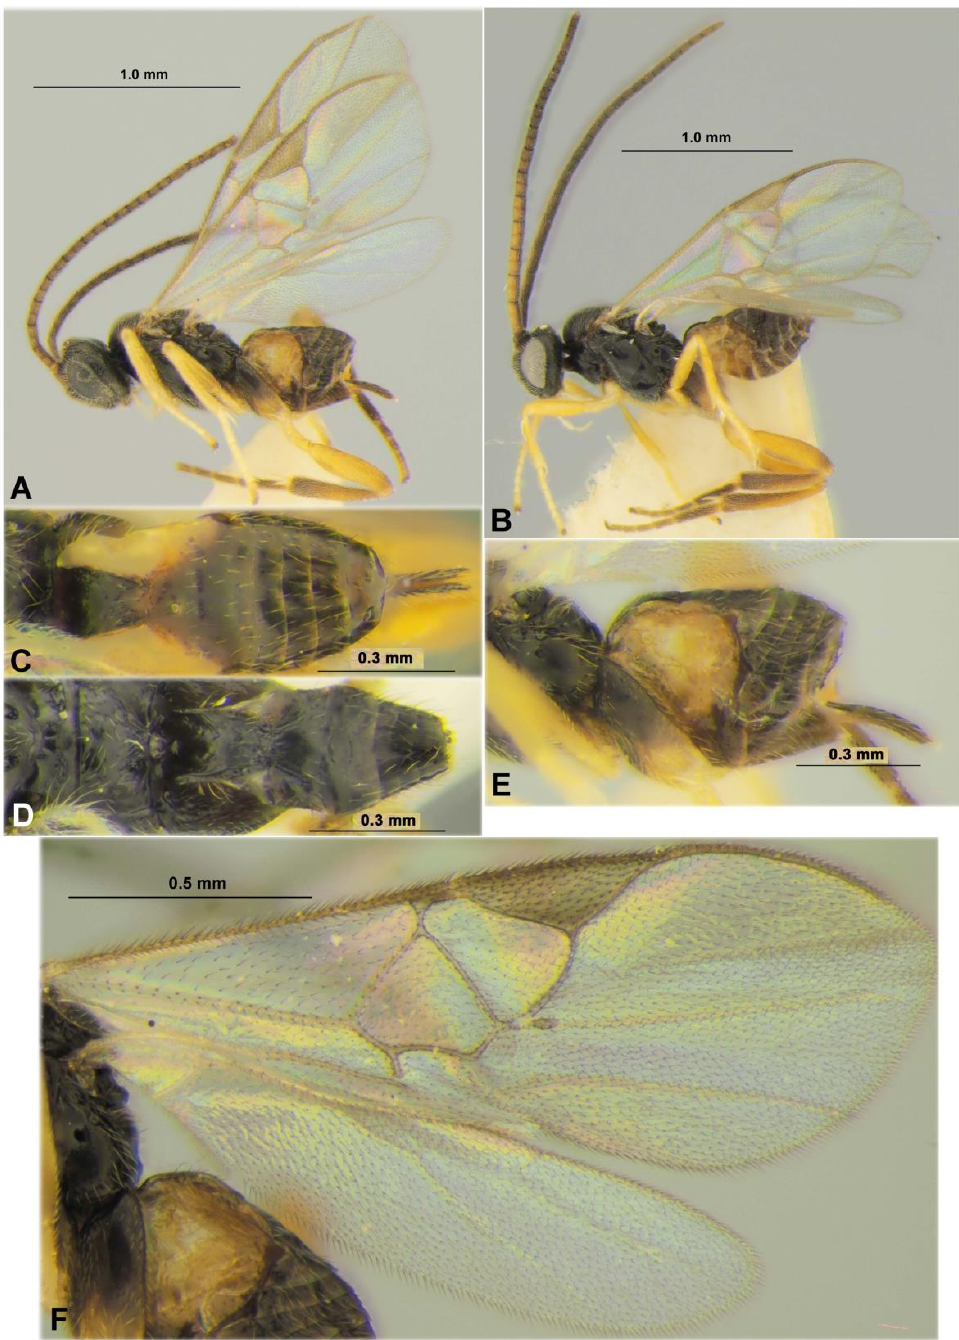
Figure 13. Microgastrinae: Pholetesor nataliae sp. nov. (paratypes), female ( A , C , E , F ) and male ( B , D ). Habitus in lateral view ( A , B ), metasoma in dorsal view ( C , D ), metasoma in lateral view ( E ), fore and hind wings ( F ). Wings. Fore wing 2.5 times longer than maximum width. Metacarp (1-R1) 1.1 times longer than pterostigma, 4.3 times longer than distance from apex of metacarp to apex of radial (marginal) cell. Pterostigma 3.1 times longer than maximum width. Radius (r) arising almost from middle of pterostigma. First radial abscissa (r) 0.8 times as long as